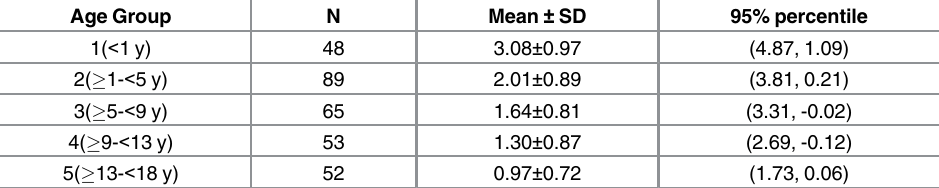
Table 5. Normal ranges of LV torsion of study subjects by age group.